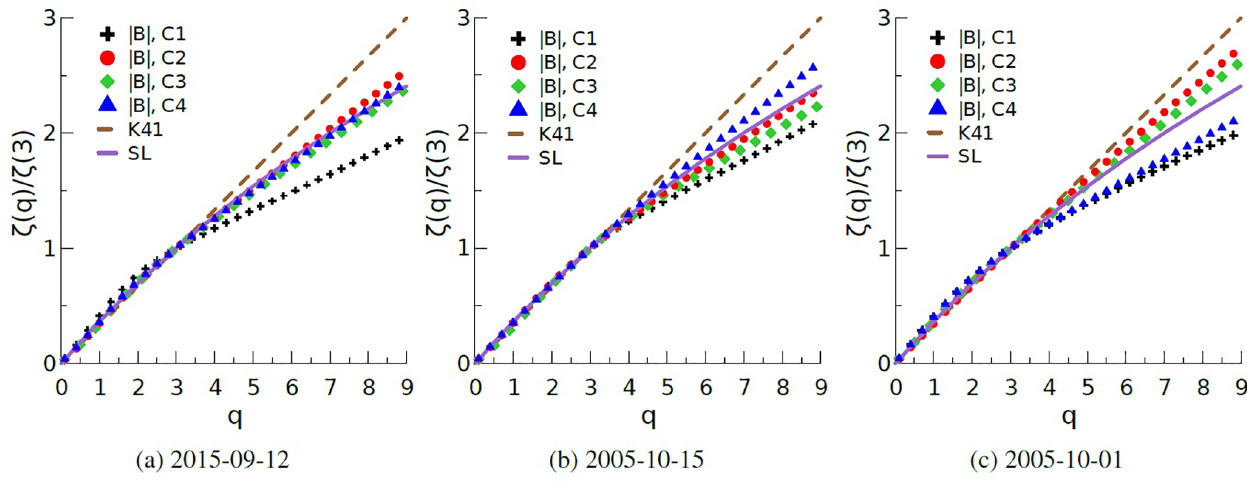
Figure 10. The results of ESS analysis (during DP). Ratio of the power of the q th-order structural function to the third-order function power. The experimental data for the magnetic field are marked with the symbol; the solid line corresponds to the value calculated using the formula in the log-Poisson cascade model for (cid:49) = β = 2 / 3 (SL), and the dotted line corresponds to the q = 3